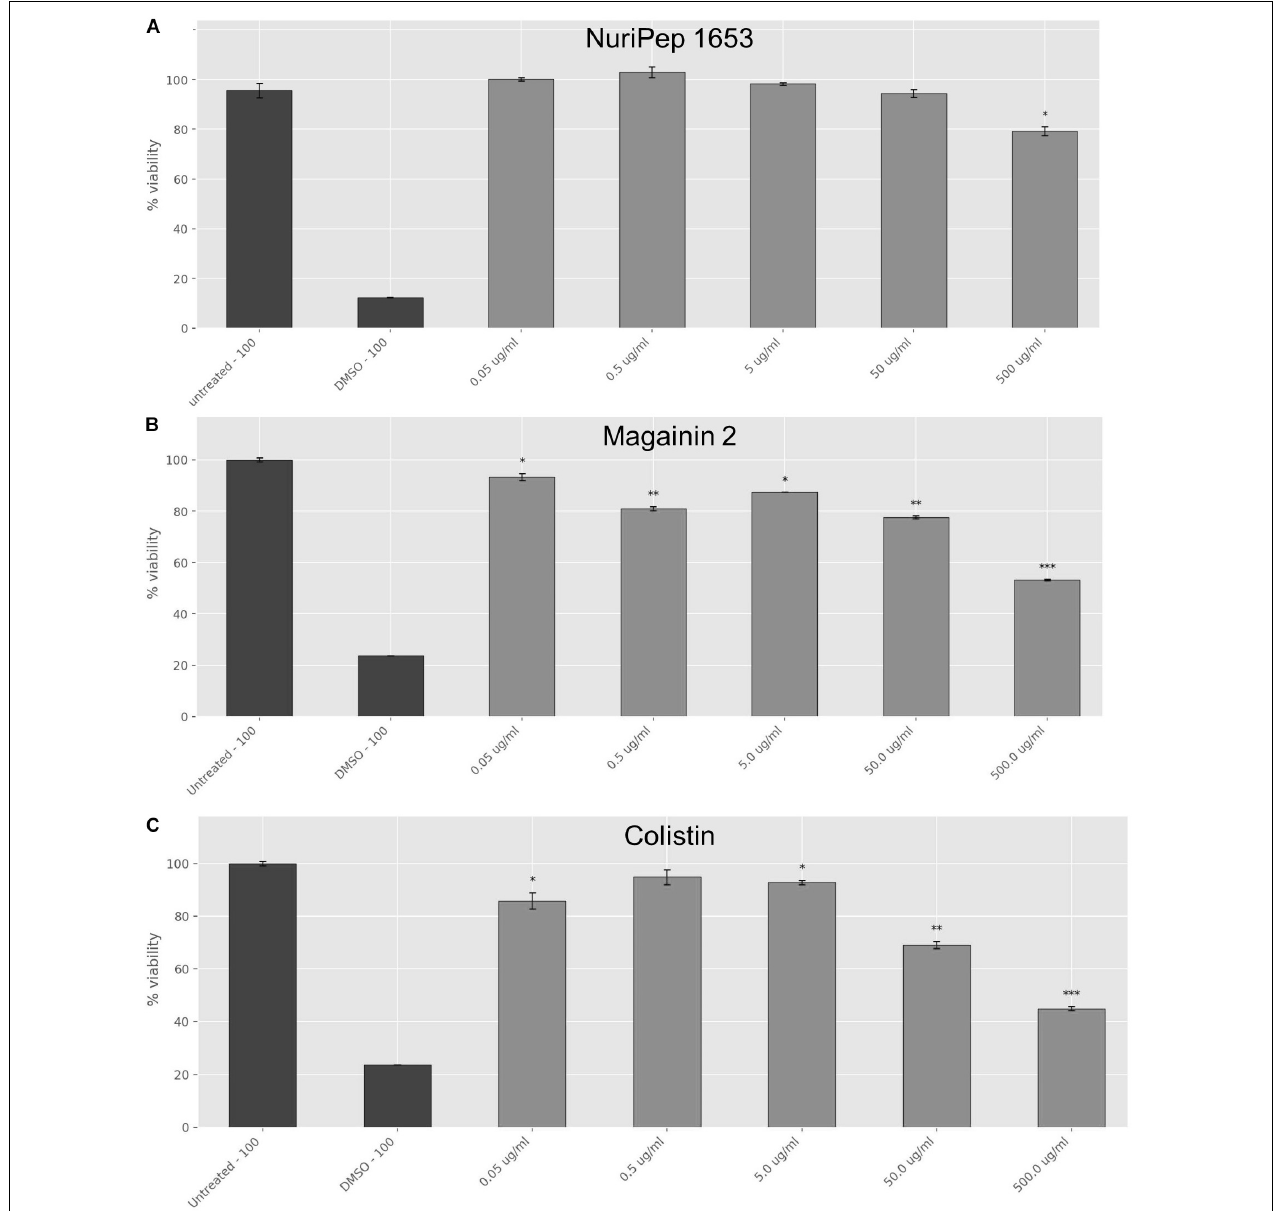
FIGURE 9 | Effects of NuriPep 1653 on the viability of differentiated human macrophages. Cells were differentiated with 10 mM PMA for 72 h into macrophages before treatment with the peptide for 24 h. Cell viability was assessed by MTT assay as per the manufacturers guidelines. Values correspond to concentrations of (A) NuriPep 1653, (B) magainin 2 and (C) colistin tested at a range from 0.5–500 µ g/mL. DMSO 100% and untreated cells served as controls. Data represent the mean of three experiments performed in triplicate and is expressed as the mean ± standard deviation. Statistical analysis was performed using a Student’s t -test where ∗ p ≤ 0.05, ∗∗ p ≤ 0.01, and ∗∗∗ p ≤